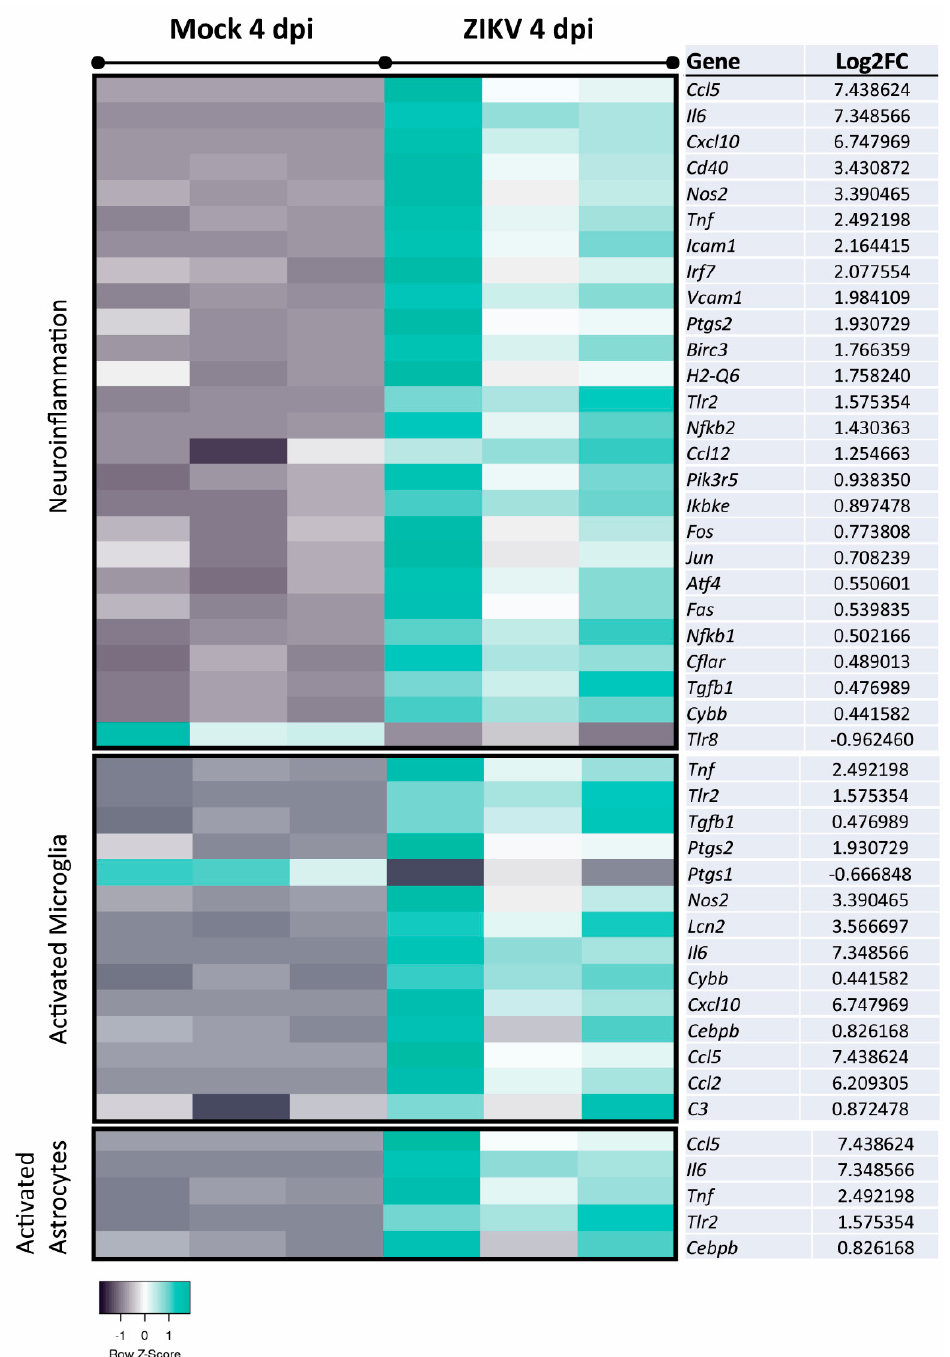
Figure 7. Analysis of DEGs implicated in neuroinflammatory pathways and the activation of microglia or astrocytes in mature CNS cultures. Expression analyses of DEGs in ZIKV-infected samples versus mock-infected samples at 4 dpi was performed using IPA and filtered to only include genes reported to be involved in neuroinflammation, microglia activation, or astrocyte activation (nervous system tissues, CNS cell lines, and neuroblastoma cell lines). Displayed DEGs were grouped and categorized using the canonical pathways and disease and function tool. Log2FC: Log2 fold change expression value.